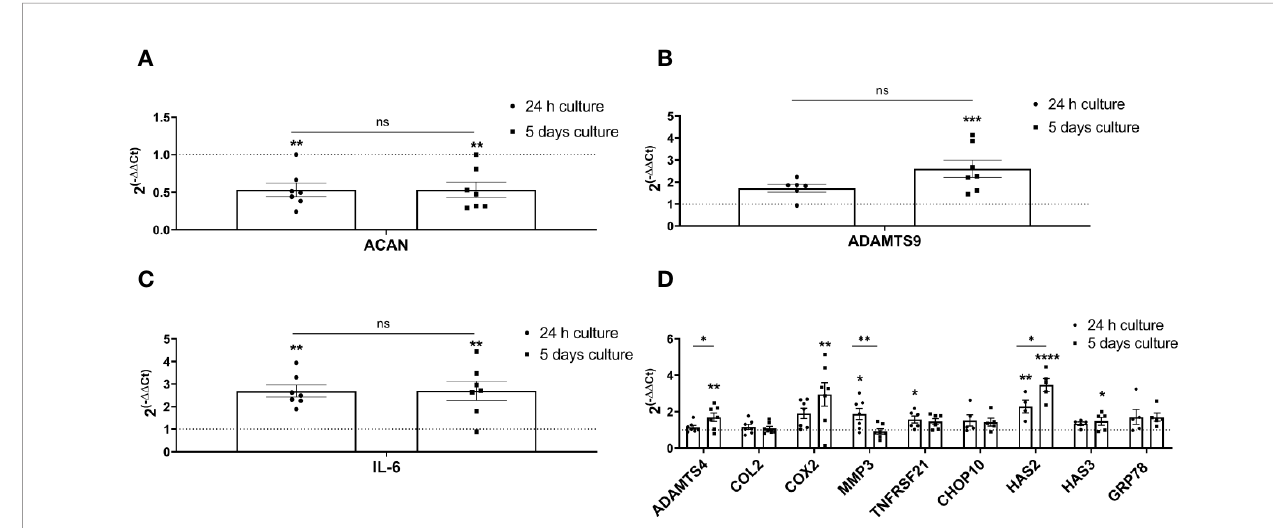
FIGURE 5 | The mRNA expression of ECM and pro-in fl ammatory targets selected based on the RNA sequencing, novelty or relevance to the IVD degeneration in bovine NP cells: (A) aggrecan (ACAN), (B) ADAMTS9, (C) IL-6, and (D) ADAMTS4, COX2, HAS2, MMP3, COL2, TNFRSF21, CHOP10, HAS3, and GRP78. Graphs show 2 − DD Ct values normalized to the iso-osmotic control (mean ± SEM, bNP P2, n = 4 – 7). Asterisks indicate statistical signi fi cance (*p < 0.05, **p < 0.01, ***p < 0.001, ****p < 0.0001) between hypo-osmotic and iso-osmotic groups, bars compare the difference between 24 h and 5-day long groups ( ns , no statistical difference de fi ned at p >